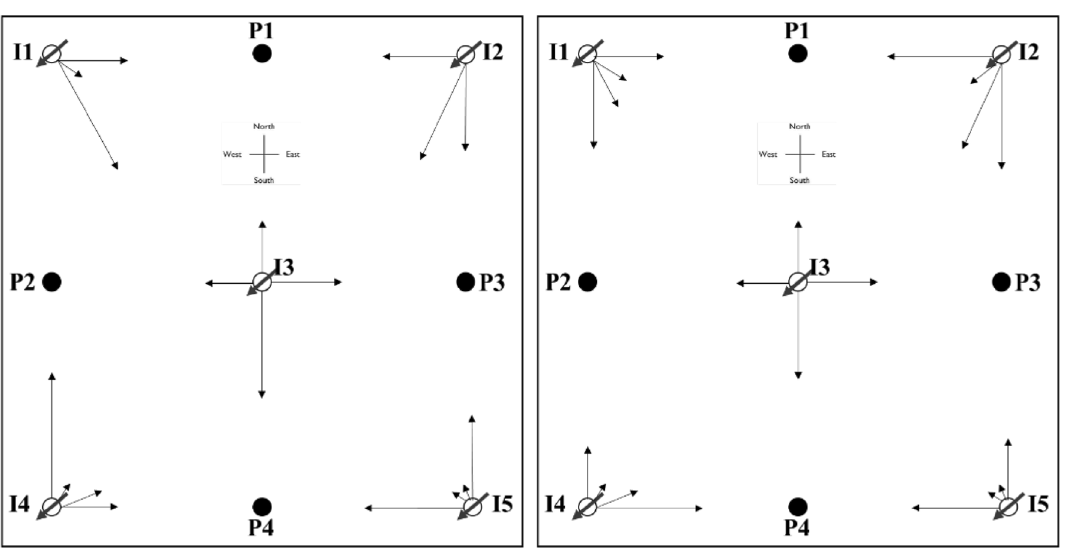
Fig. 12 Distribution of f ij in case II by CRMP (left) and D-CRMP (right). Each black arrow and its length represent the connectivity and magni- tude,